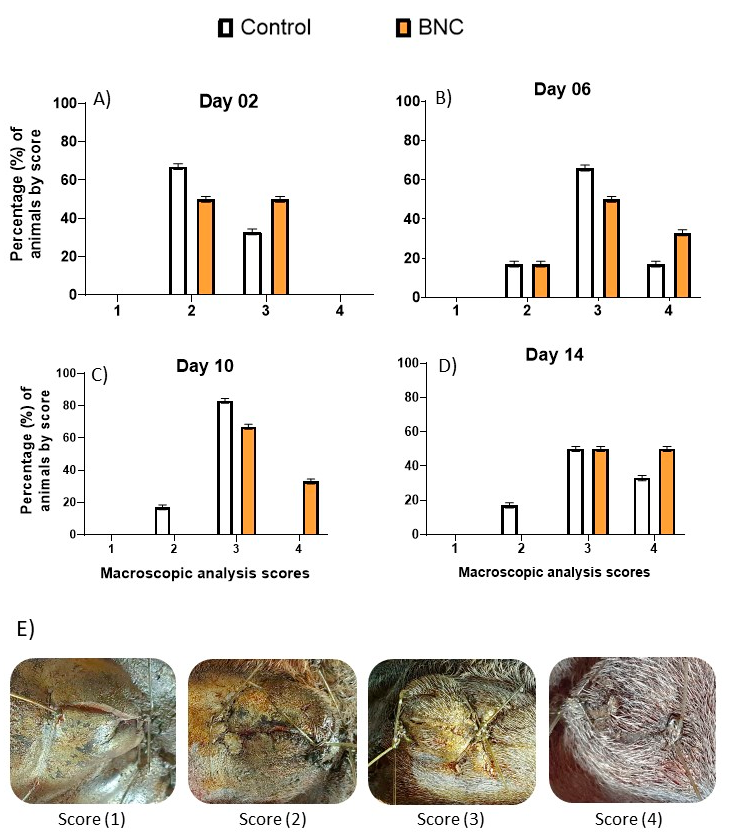
Figure 1. Descriptive macroscopic evaluation of the surgical wounds of animals from Experiment I ( n = 12) by score at 2 days ( A ), 6 days ( B ), 10 days ( C ), and 14 days ( D ) post-surgery. In letter ( E ), typical images for each score, been: 1—Moderate inflammation, no epithelialization; 2—Mild inflammation, initial epithelialization; 3—No inflammation, presence of epithelialization; 4—Hair growth, signs of epithelialization. Control group = standard treatment (antisepsis with topical PVPI solution followed by larvicidal repellent); BNC group = standard treatment + bacterial nanocellulose membrane. Finally, a paired evaluation between the control and the BNC horns was